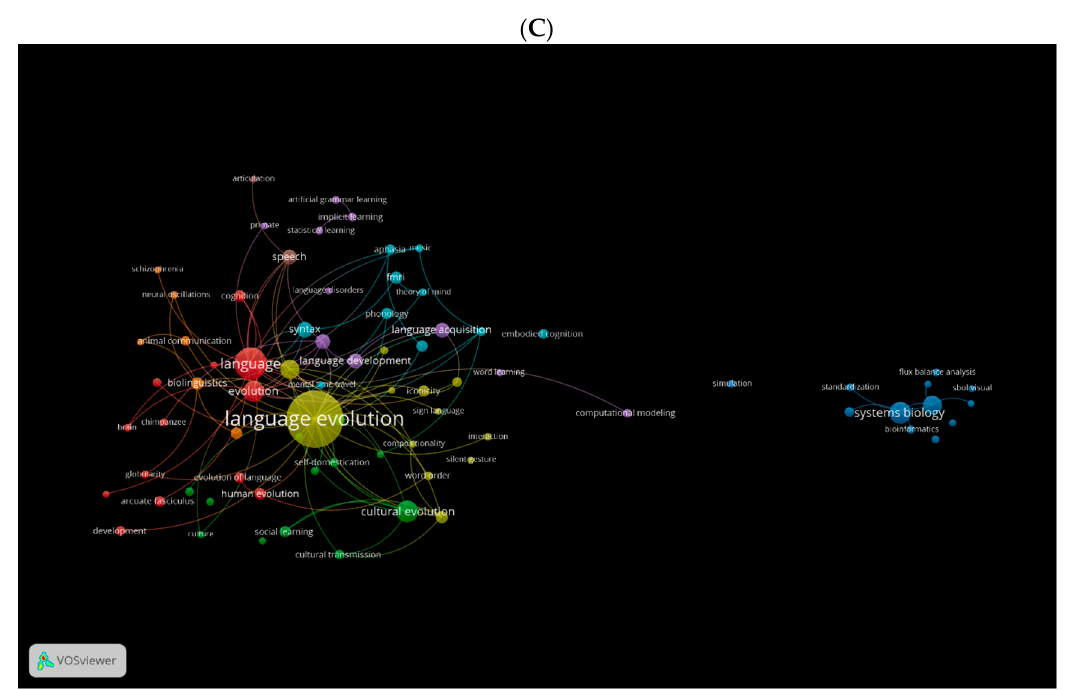
Figure 10. Cooccurrence by author keywords network visualisation in biolinguistics. ( A ) (Scopus), ( B ) (WOS), ( C ) (Lens).